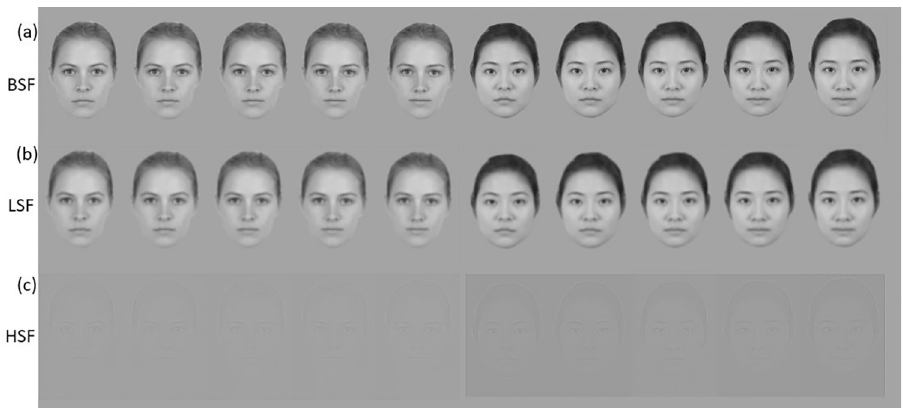
Fig 1. Stimuli used in the present study. The original unfiltered images of the five variations of the female White identity and the female Asian identity used as stimulus material in the Broad-Spatial-Frequency (BSF) condition, representing two trustworthiness continua ranging from 1 (very untrustworthy) to 5 (very trustworthy) (a). The White and Asian Low-Spatial-Frequency (LSF) (b) and High-Spatial-Frequency (HSF) (c) trustworthiness continua generated by filtering the original